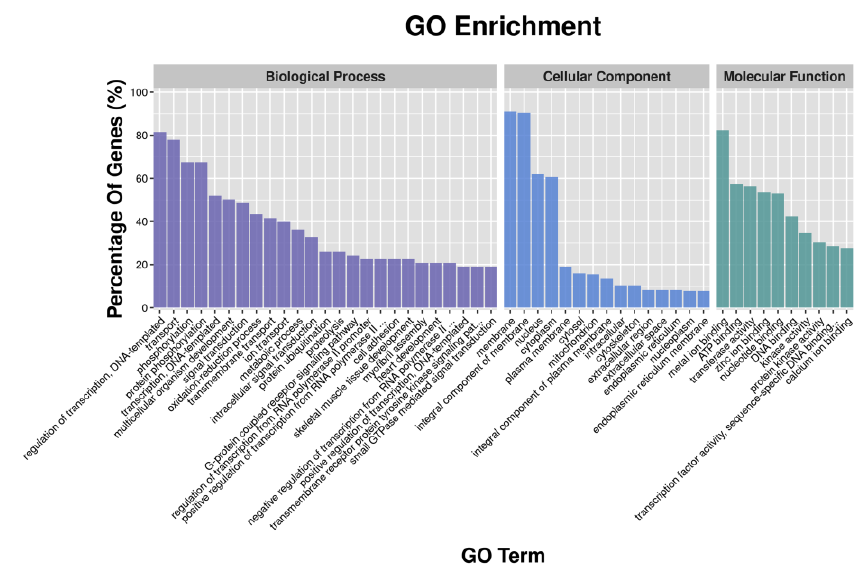
Figure 2. Functional classification of the differential expression target genes (DETGs) of differential expression miRNAs according to GO category.